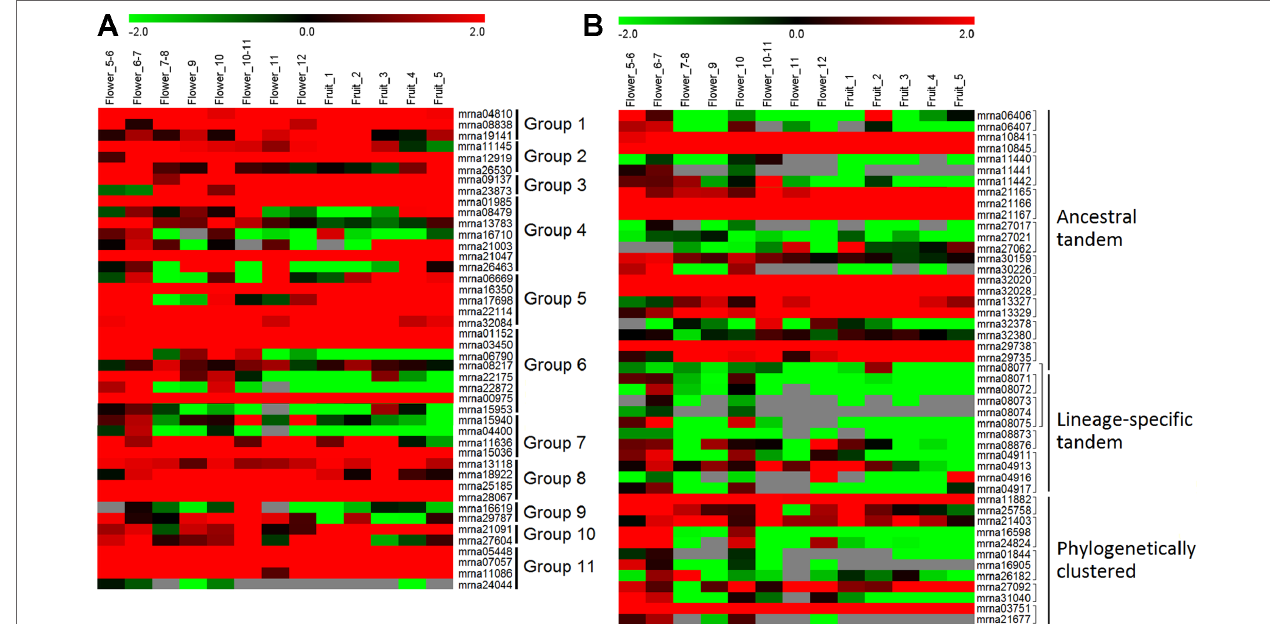
FIGURE 4 | Expression profiles of FveERF genes in different stages of Fragaria vesca flowers and early-stage fruits. (A and B) The mRNA levels of the non- tandem (A) and tandem/phylogenetically clustered (B) FveERF genes. Genes located in the same tandem repeat or in a phylogenetic cluster are grouped together. Mrna08077 forms an ancestral tandem repeat with mrna08071–mrna08075. Mrna21403 forms a phylogenetic cluster with mrna29735. Data were retrieved from http://bioinformatics.towson.edu/strawberry/ (Hollender et al., 2012; Darwish et al., 2013; Kang et al., 2013). Expression levels were calculated in the log2 scale. For